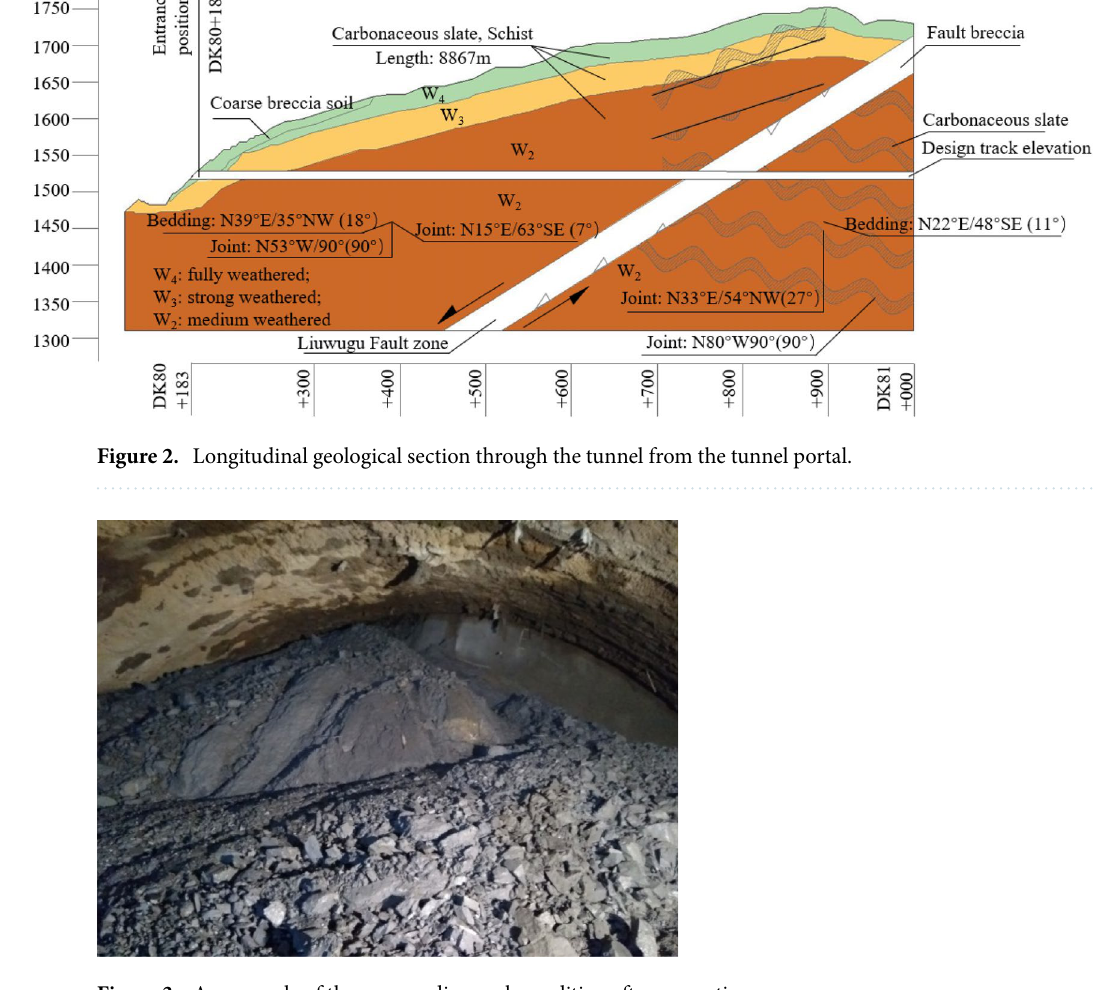
Figure 3. An example of the surrounding rock condition after